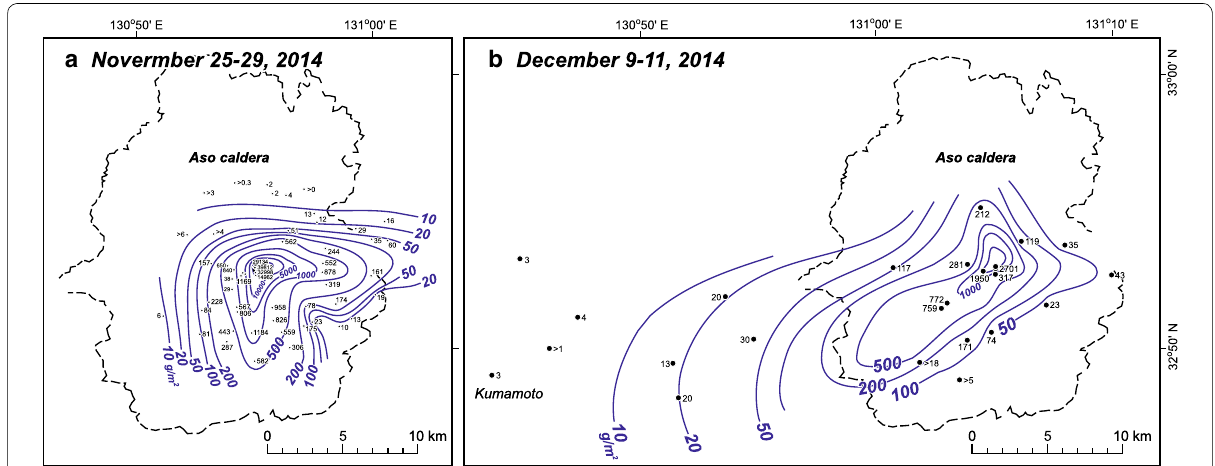
Fig. 3 Distribution maps of the November 25–29, 2014 ash-fall deposit ( a ) and the December 9–11, 2014 ash-fall deposit ( b )